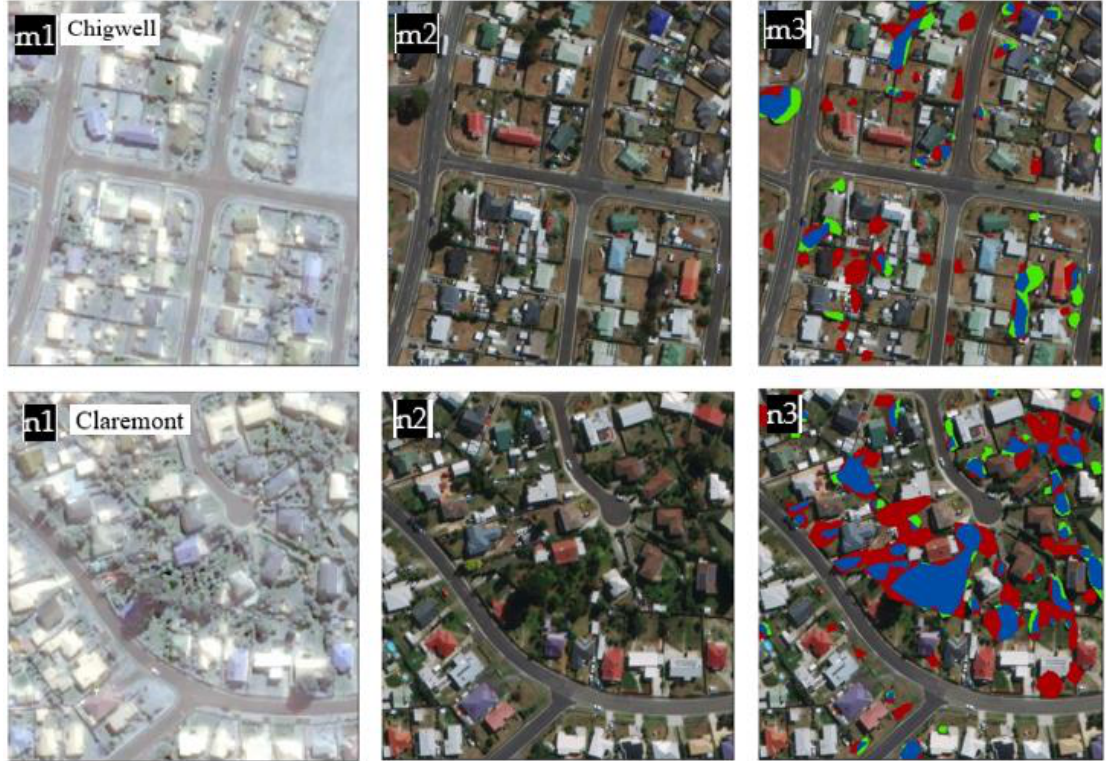
Figure A1. From left to right, first column (1) represents the satellite images of 2005; second column (2) represents aerial images of 2015 ( a2 , b2 , c2 ) and Google images of 2016 (d2 onwards) and the third column (3) represents the tree cover area changes between 2005 and 2015 / 16 in terms of tree cover area loss (red), gain (green) and persistence (blue).